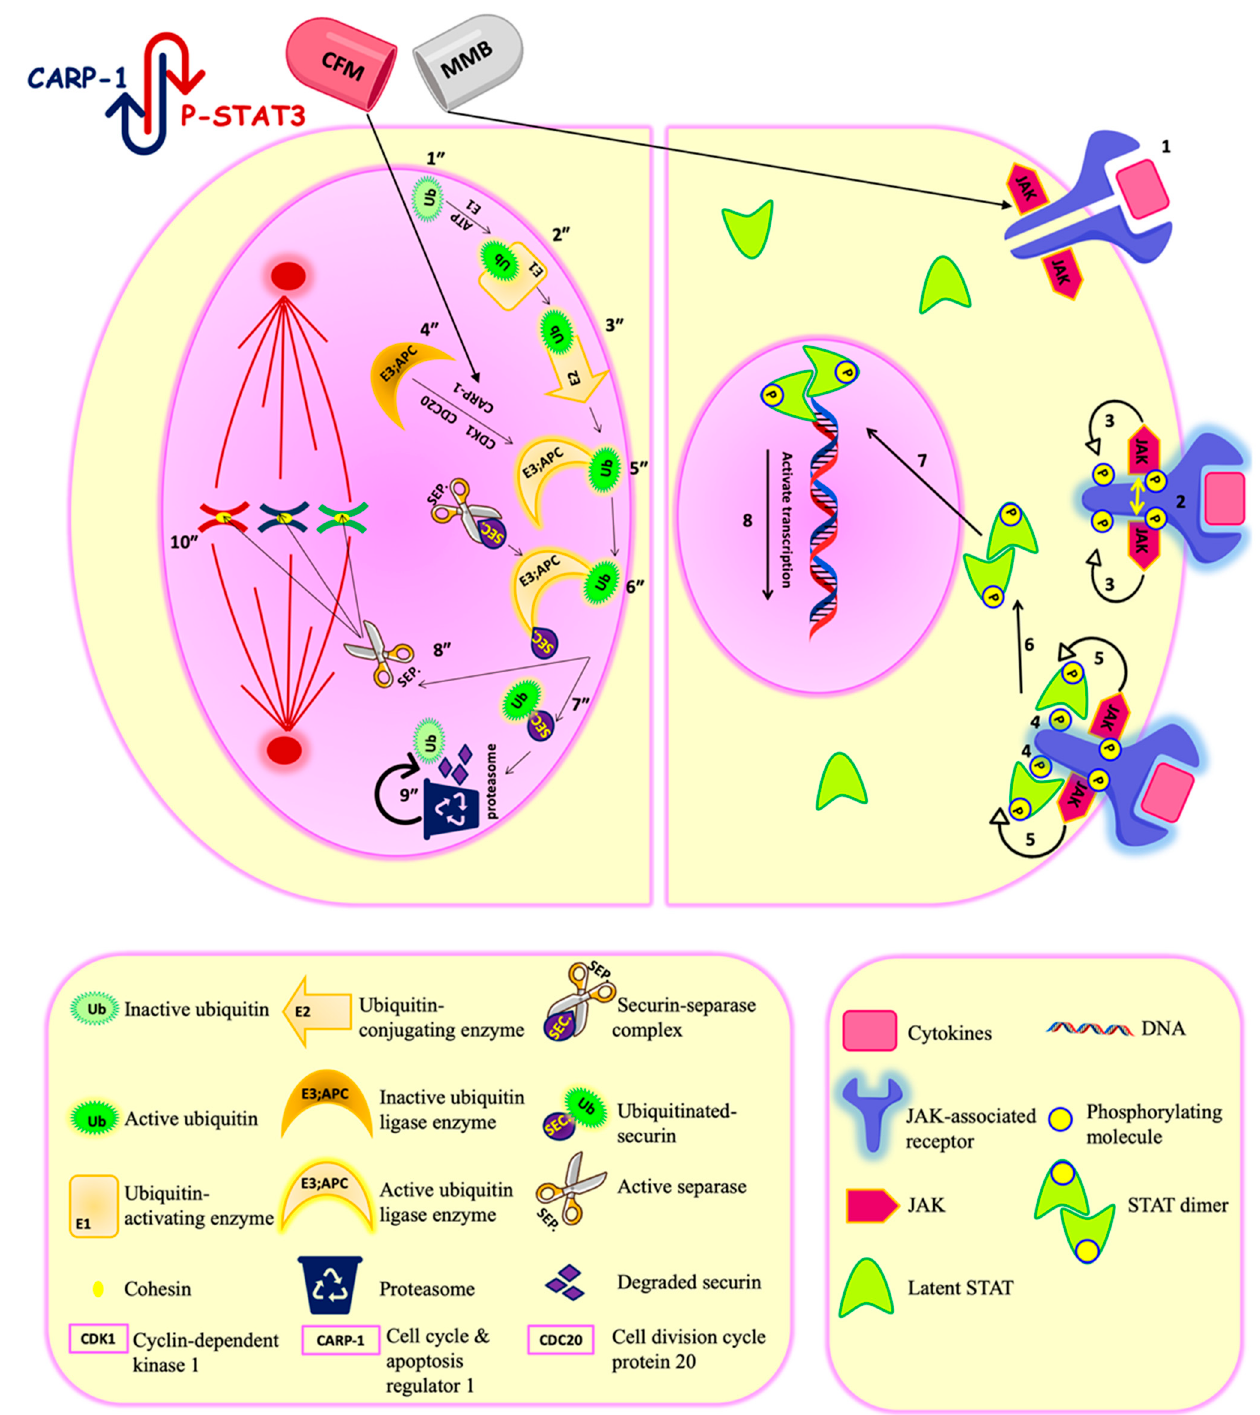
Figure 1. Momelotinib and CFM4.16 synergistic combination. Momelotinib is a JAK-STAT inhibitor. JAK-STAT pathway is a direct signaling pathway transfer the signal from extracellular to nucleus to control the expression of certain genes. The upregulation of the JAK-STAT pathway is the key player in different cancers, and its regulation is under clinical investigation for cancer therapy. The principal components of this pathway are: cytokines-receptor complex, JAK, and STAT proteins. Mechanistically, when the ligand bind to its corresponding JAK-associated receptor (1), the receptors arms are brought into proximity, which enables transphosphorylation between the two JAK molecules (2). The activated phosphorylated JAK subsequently phosphorylates the receptor arms, which is the binding site for the latent transcription factors STAT (3). After the STAT molecules bind to the receptor arms (4), they become ready for phosphorylation by JAK (5). Once phosphorylated, the two STAT monomers dimerize through reciprocal phosphotyrosine-SH2 domain interaction (6). The STAT dimer is an active transcriptional factor that is translocated to the nucleus (7) and binds to a specific DNA sequence in the target gene promoters by DNA-binding domain to control transcription of specific genes (8). Momelotinib